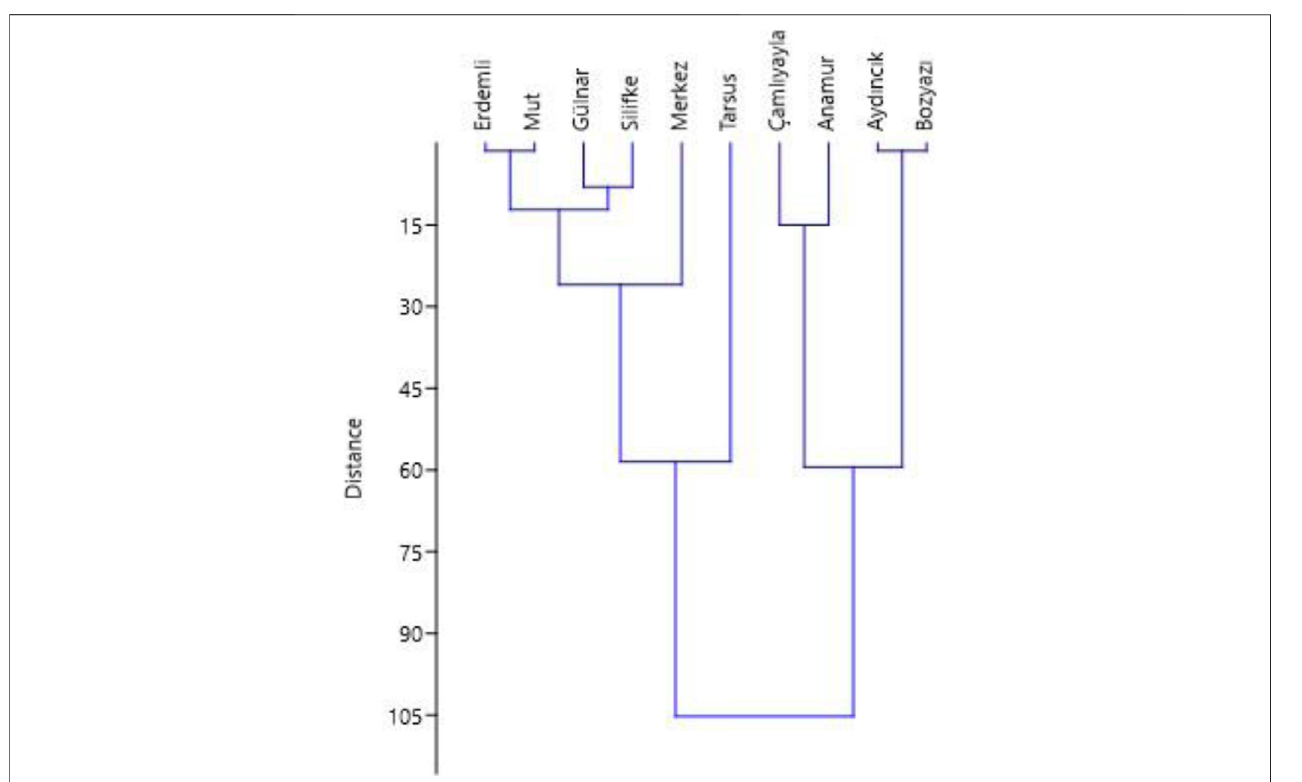
FIGURE 9 | Dendogram showing UPGMA clustering (with Euclide distance) of districts (those where over 10 interviews were carried out).